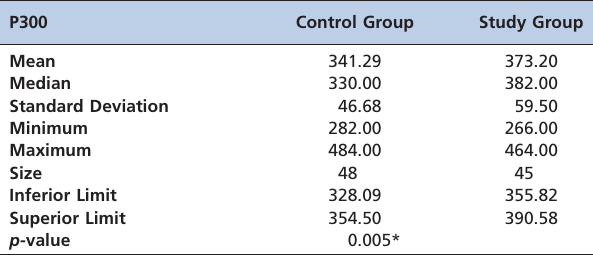
Table 5 - The control (CG) and study (SG) group comparisons regarding the P300 latencies in the first electrophysiological